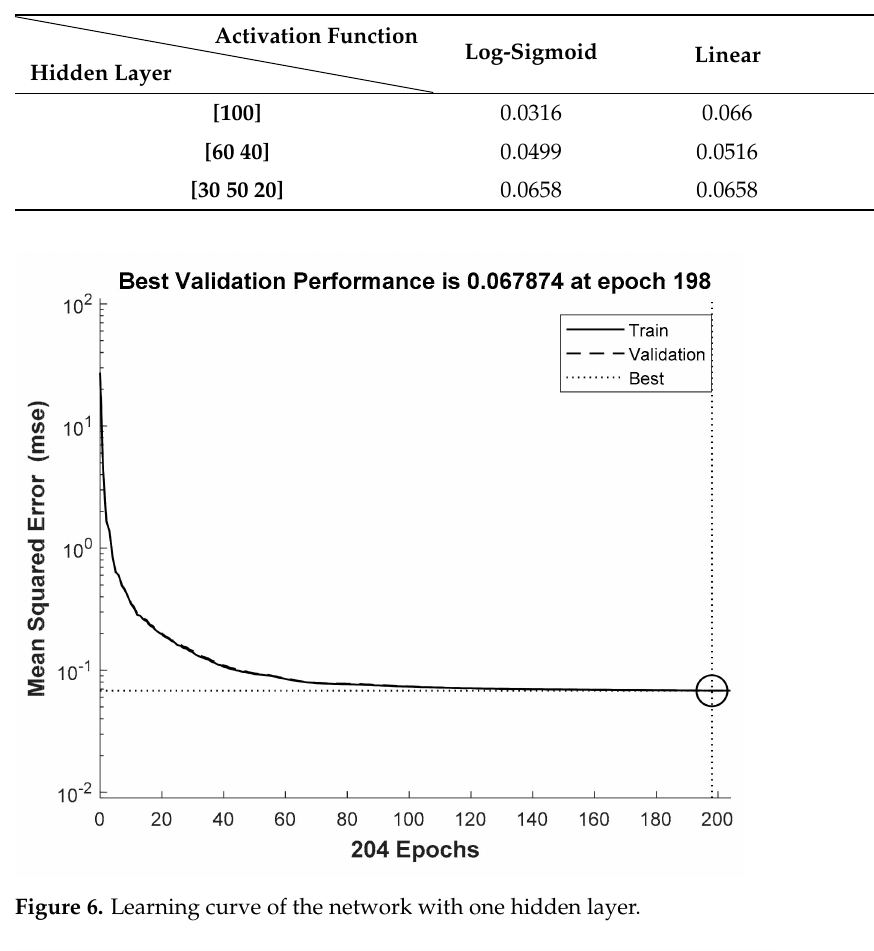
Table 5. MSE of the neural network depending on activation function.